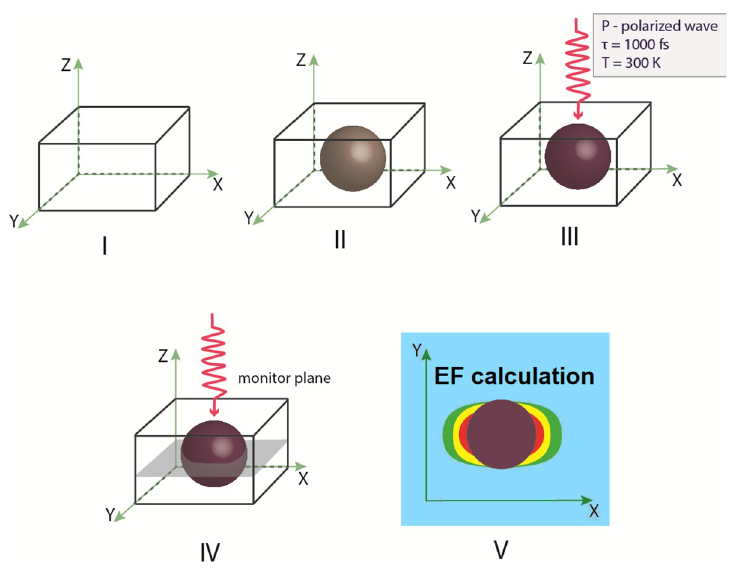
Fig 1. The schematic diagram of FDTD simulation process.